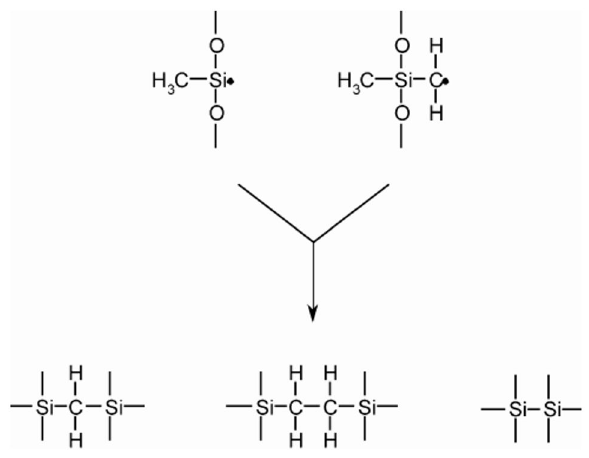
Figure 1. Cross-linking of polydimethylsiloxane